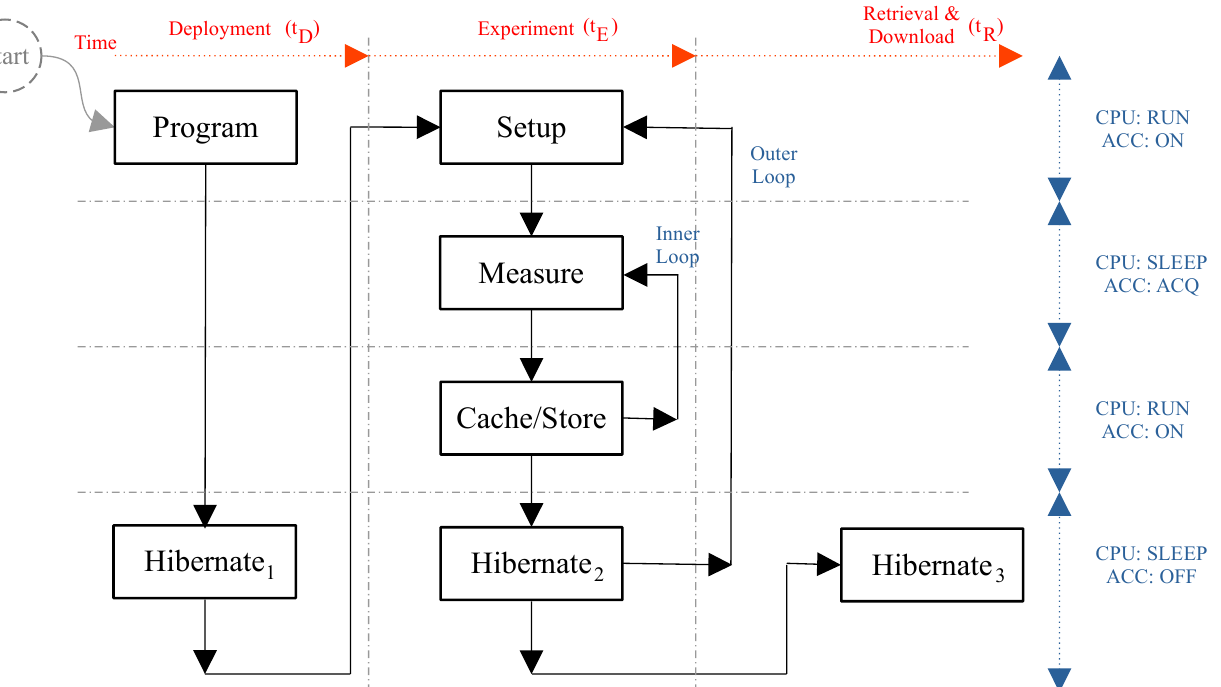
Figure 6. The execution schedule that was implemented for the proposed deep-water current